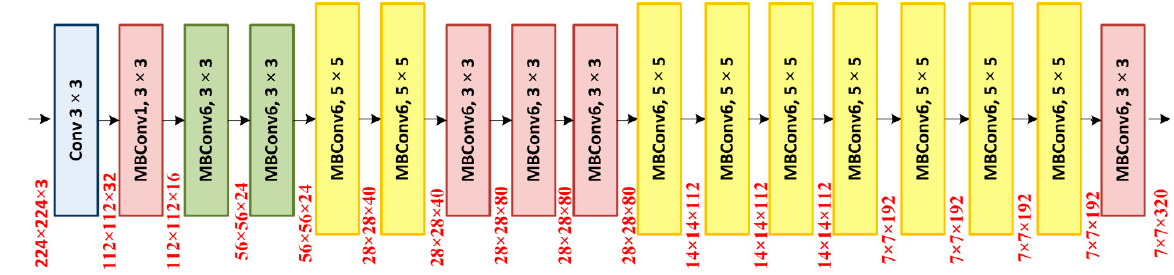
Figure 4. EfficientNet-B0 architecture.